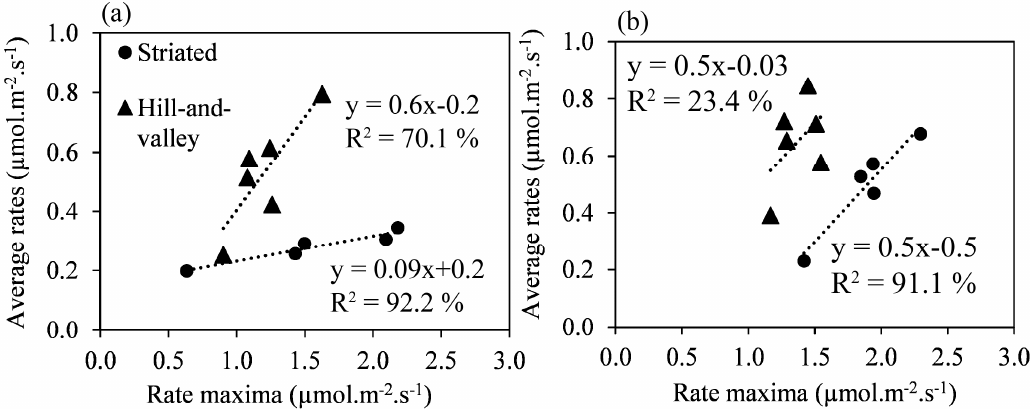
Figure 10. The e ff ect of maximum rates on the average rates showing the contrast between the statistics Figure 10. The effect of maximum rates on the average rates showing the contrast between the of a single measurement and the statistical analysis of a set of ten di ff erent calcite patches: ( a ) Single statistics of a single measurement and the statistical analysis of a set of ten different calcite patches: patch with di ff erent surface morphologies; ( b ) set of ten analyzed calcite cement patches also separated ( a ) Single patch with different surface morphologies; ( b ) set of ten analyzed calcite cement patches by surface also separated by surface morphology.